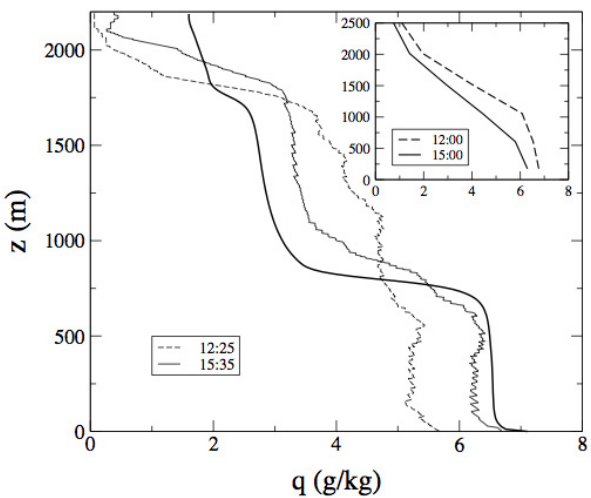
Fig. 8. Specific humidity profiles. Thin lines are the radiosoundings at 12:25 and 15:35UTC of 16 June 1992. The thicker line is the profile from LES recorded at 15:30UTC. In the inset, two profiles obtained from the WRF